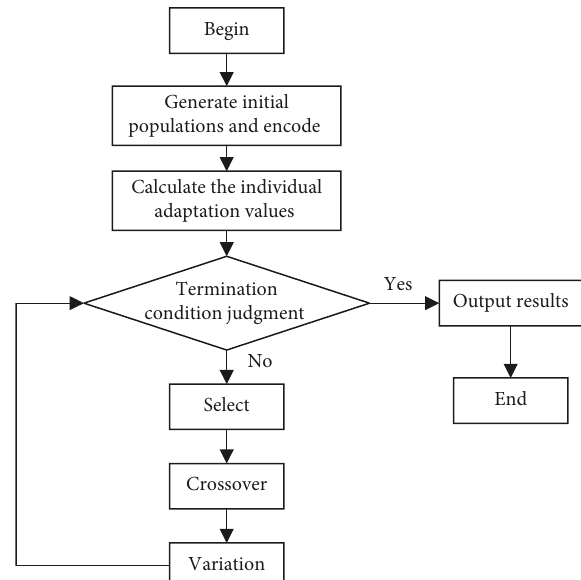
Figure 4: Flowchart of the genetic algorithm.